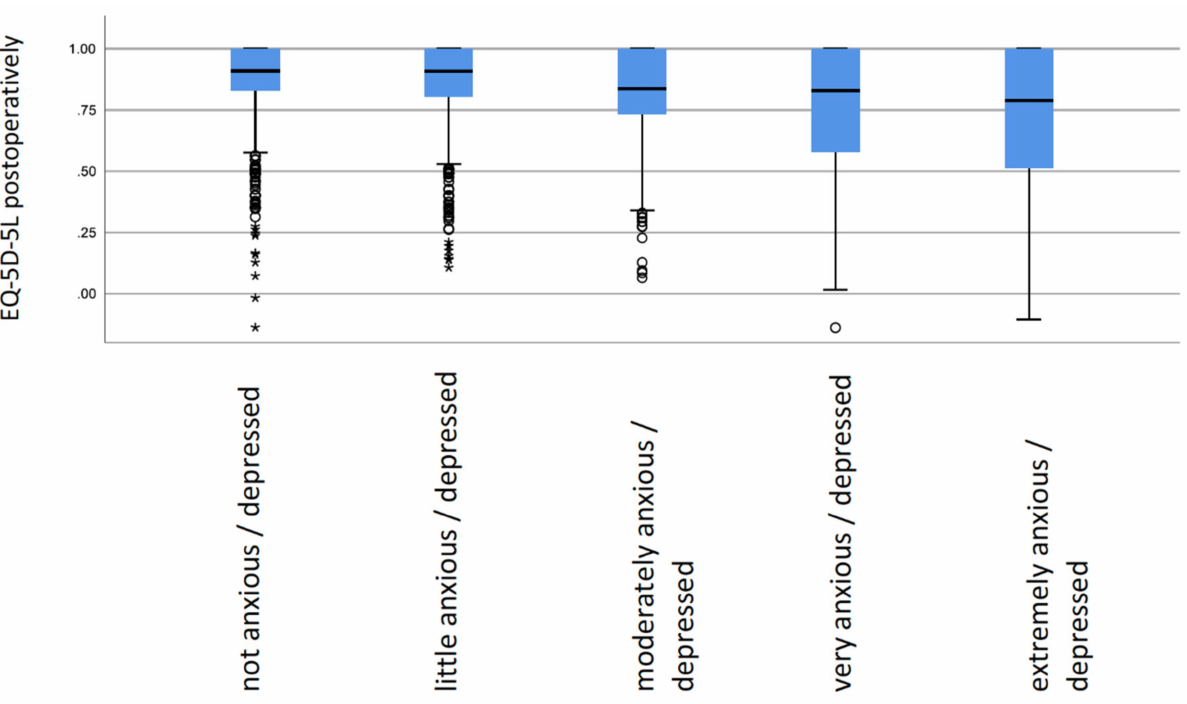
Figure 2. Boxplot: EQ-5D postoperatively according to preoperative anxiety/depression status.* are